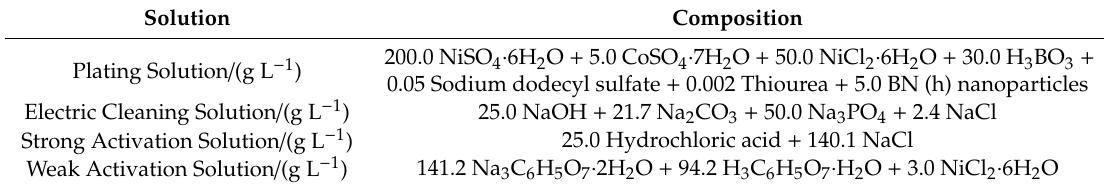
Table 1. Di ff erent solution constituents used for this